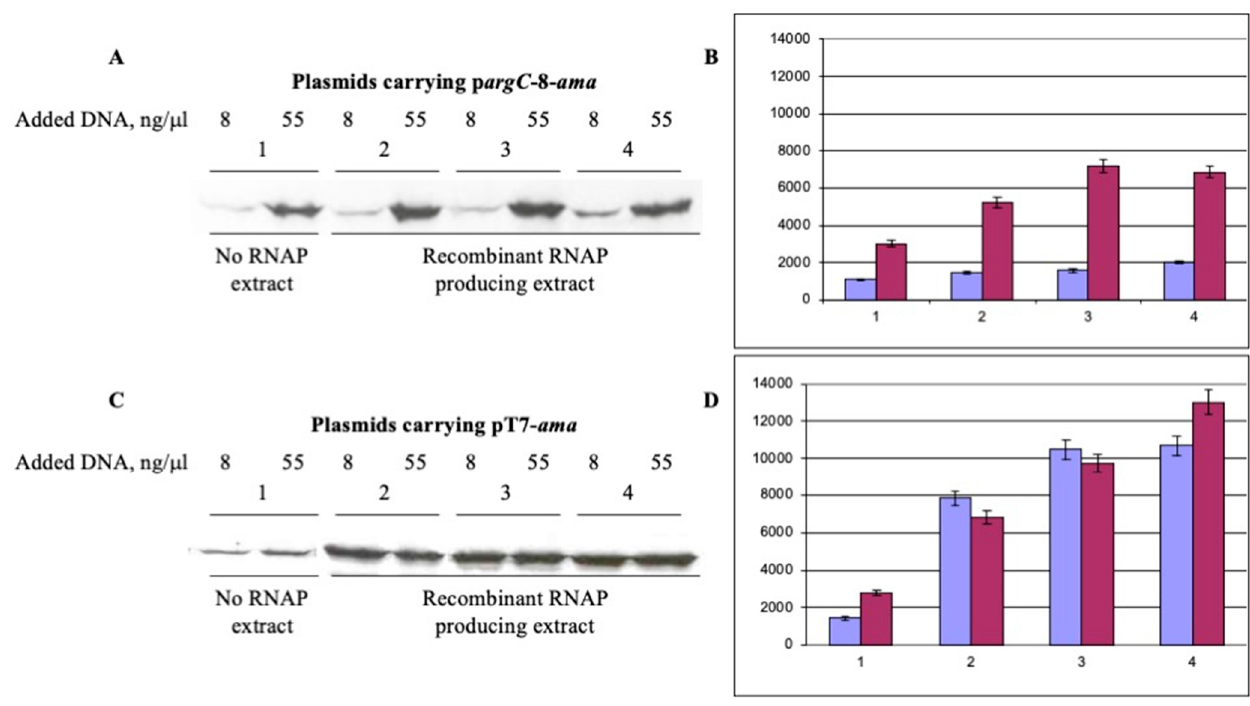
Figure 4. Comparison of aminoacylase synthesis under the control of p argC and pT7 promoters in cell ‐ free extracts without and with induction of E. coli RNA polymerase α , β , β ’ and ω subunits. DNA of plasmids pET ‐ p argC ‐ 8 ‐ amaA ( A , B ) and pET ‐ pT7 ‐ amaA ( C , D ) was added to the reaction mixture at concentrations of 8 ng/ μ L (color violet) and 55 ng/ μ L (color mauve). Lane 1 plasmidless E. coli BL21 Star (DE3) incubated with IPTG; lanes 2, noninduced E. coli BL21 Star (DE3) (pETDuet ‐ rpoA ‐ rpoB /pACYCDuet ‐ rpoC ‐ rpoZ ); lane 3, E. coli BL21 Star (DE3) (pETDuet ‐ rpoA ‐ rpoB / pACYCDuet ‐ rpoC ‐ rpoZ ) induced with IPTG at OD 600 0.5; lane 4, E. coli BL21 Star (DE3) (pETDuet ‐ rpoA ‐ rpoB / pACYCDuet ‐ rpoC ‐ rpoZ ) induced with IPTG at OD 600 0.8. The incorporation of 35 S methionine into the synthesized aminoacylase was assessed using a PhosphorImager. Histograms represent data from two experiments.